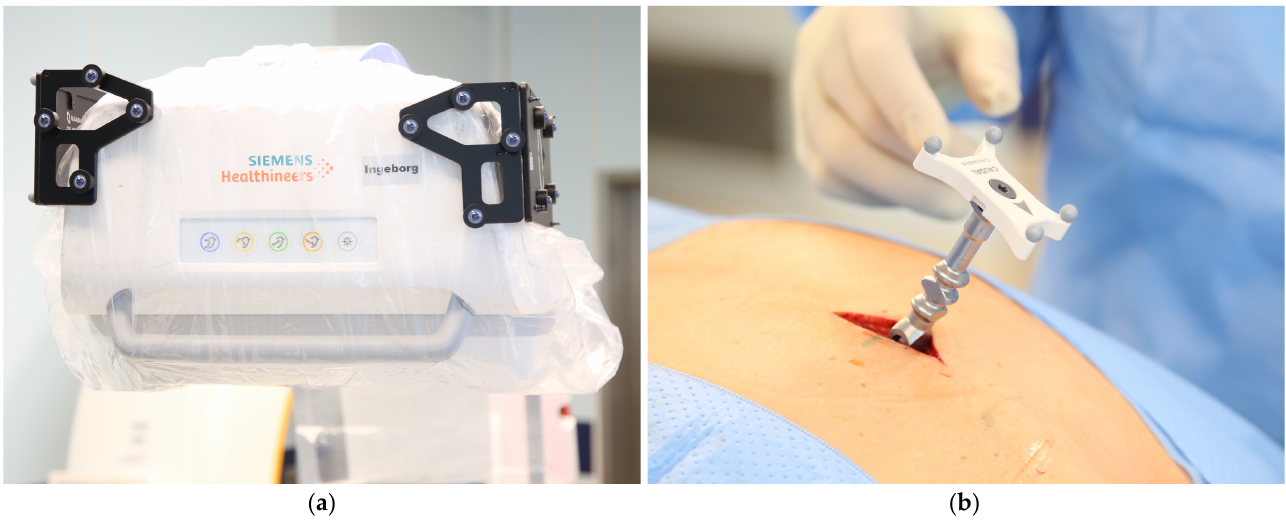
Figure 2. ( a ) Flat panel detector of the C-arm Cios Spin with sterile draping and referencing array. The spheres are only mounted on the side used for the procedure; ( b ) patient array attached to a spinous process close to the region of interest.